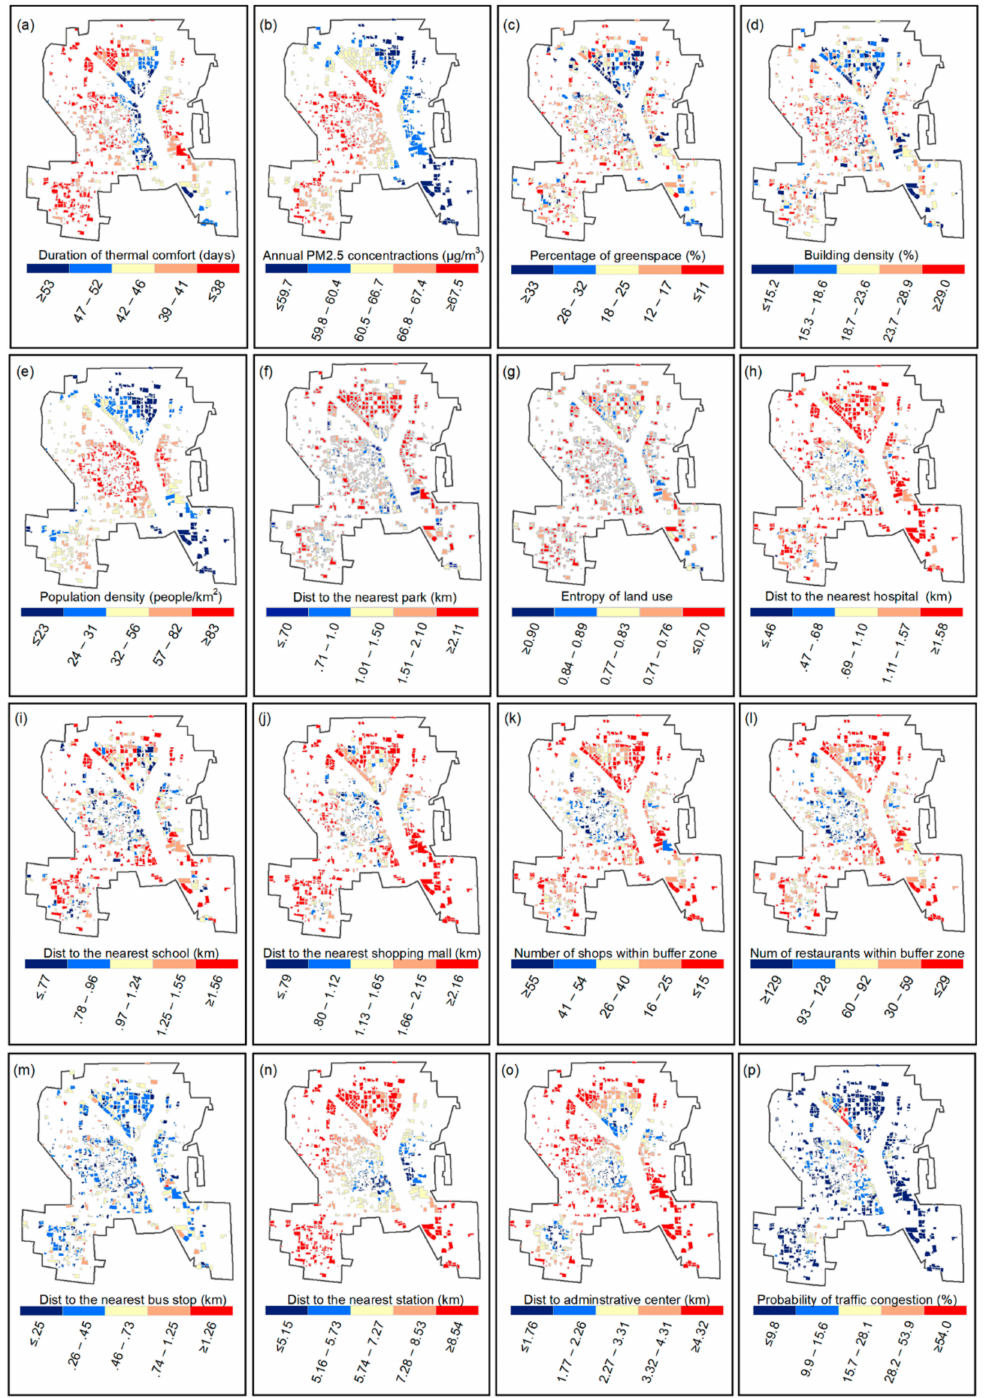
Figure 6. Single–index assessment of livability based on the 16 indices under 4 dimensions, as shown in Table 1. ( a , b ) spatial patterns of index values within the dimension of environmental health; ( c – g ) spatial patterns of index value within the dimension of environmental comfort; ( h – l ) spatial patterns of index values within the dimension of living amenity; ( m – p ) spatial patterns of index values within the dimension of travel